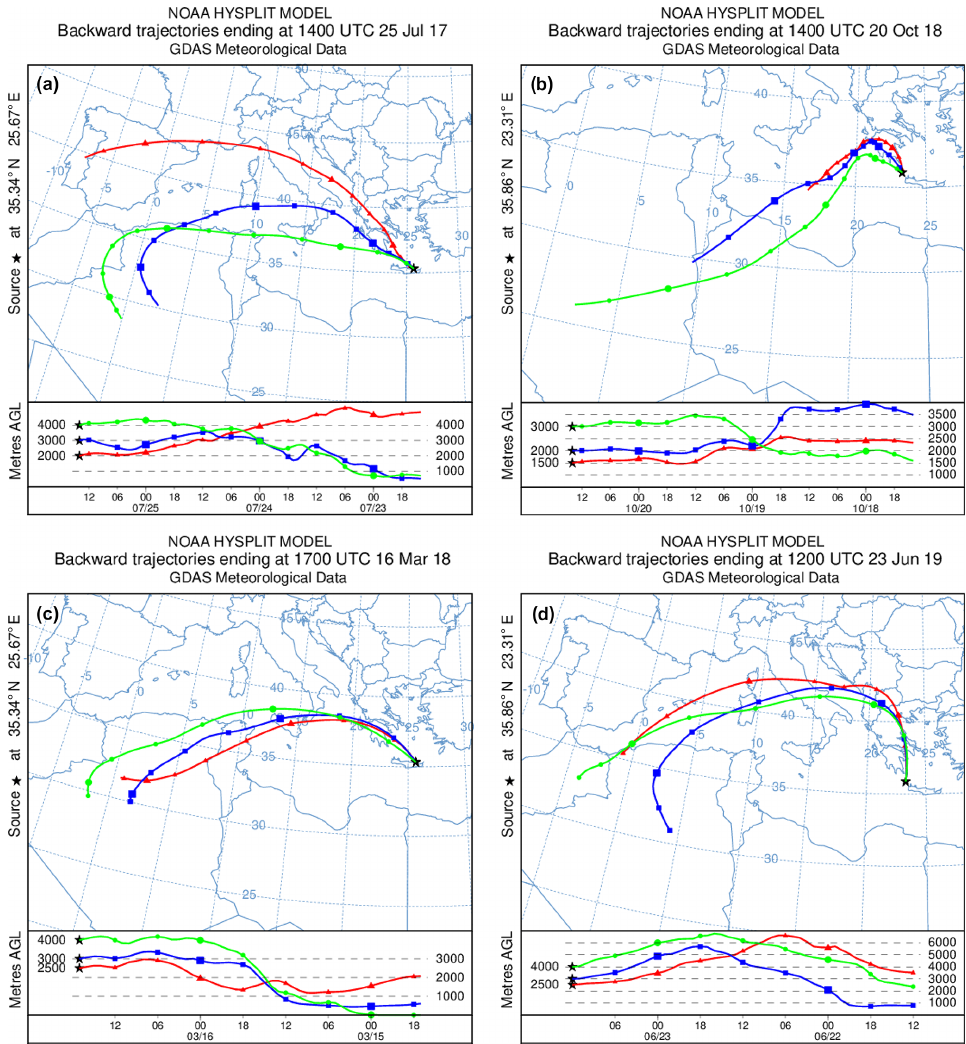
Figure 1. NOAA HYSPLIT backward-trajectory model with GDAS assimilated data input for (a) 25 July 2017 with 72h backward prop- agation of air masses towards Finokalia, (b) 20 October 2018 with 72h backward propagation of air masses towards Antikythera, (c) 16 March 2018 with 48h backward propagation of air masses towards Finokalia and (d) 23 June 2019 with 48h backward propagation of air masses towards Antikythera (https://www.ready.noaa.gov/HYSPLIT.php, 3 July 2020). Please note that some dates in the figure are given in the format of month